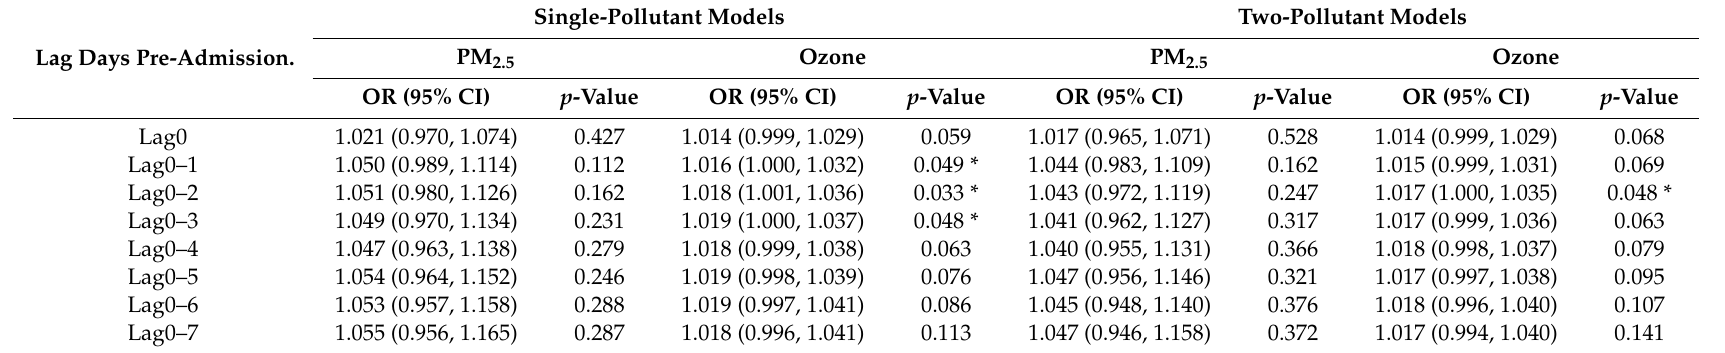
Table 3. Results of multivariate binomial logistic regression analysis in single- and two-pollutant models.